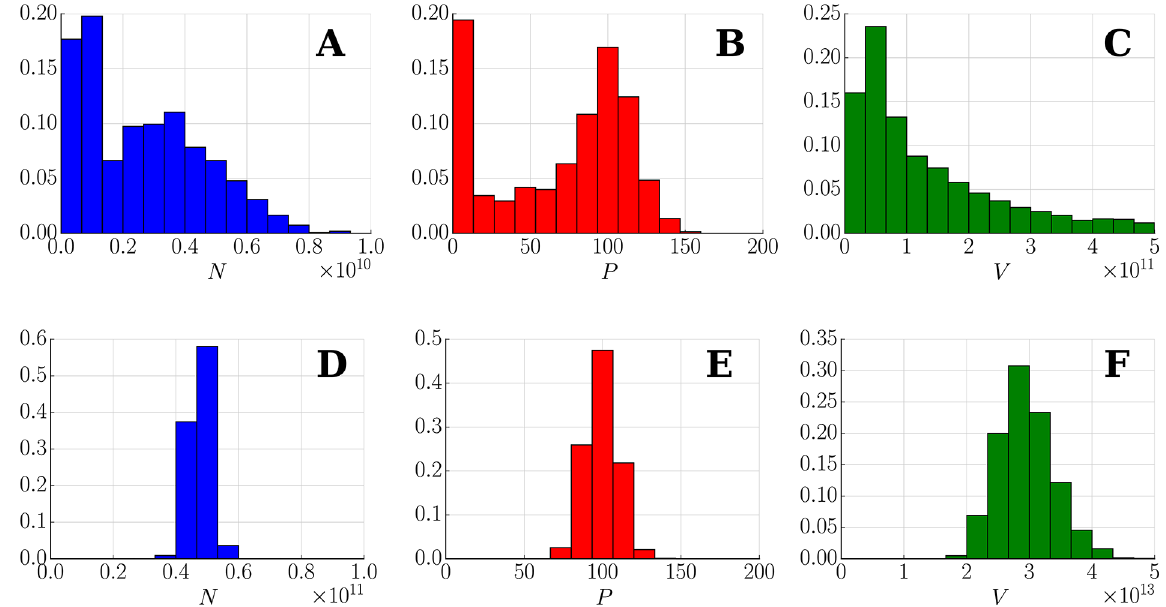
Fig 10. Stochastic population distribution of LLC. Distribution of ( N , P , V ) for 2000 realizations and parameters of Table 3. (A), (B) and (C): Histogram at time t = 5 days. (D), (E) and (F): Histogram at time t = 50 days for all the tumours that survived the first week.